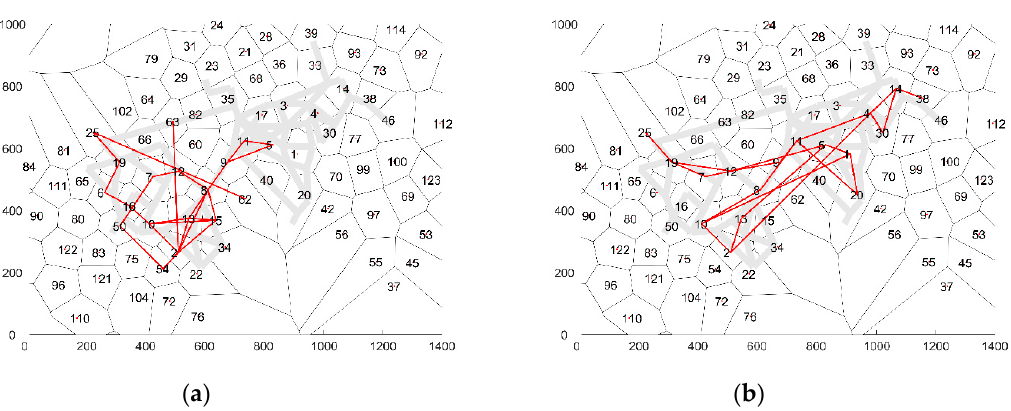
Figure 4. Two examples of cell sequences, where ( a ) displays a trajectory that only visited one side of the terrain, ( b ) presents a trajectory that covered the entire